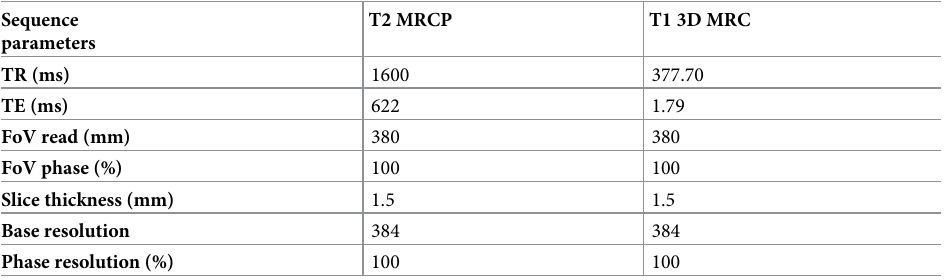
Table 1. Imaging parameters of the institutional standard T2 MRCP protocol and T1 3D MRC parameters. Sequence